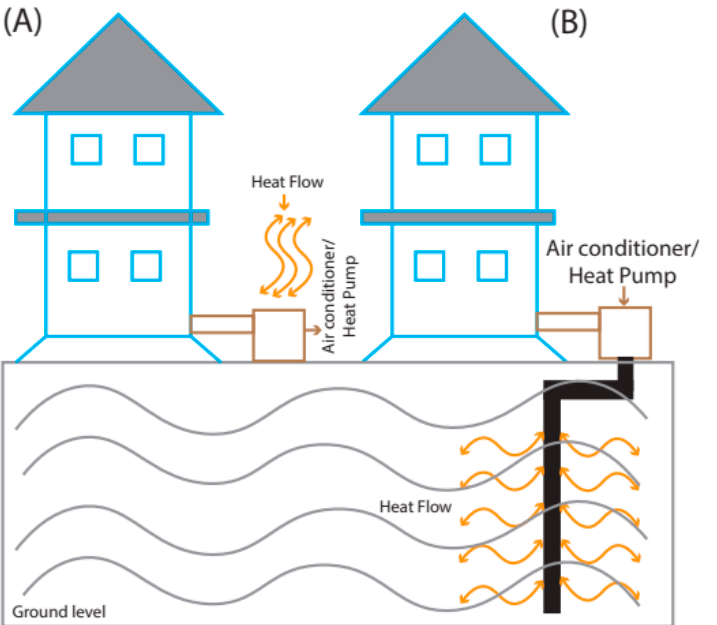
Figure 2. ( A ) Schematic of the heat-exchange arrangement for a heat pump system that heats or cools using air exchange. ( B ) Heat-exchange arrangement for a heat pump system that uses the ground rather than air to exchange heat.